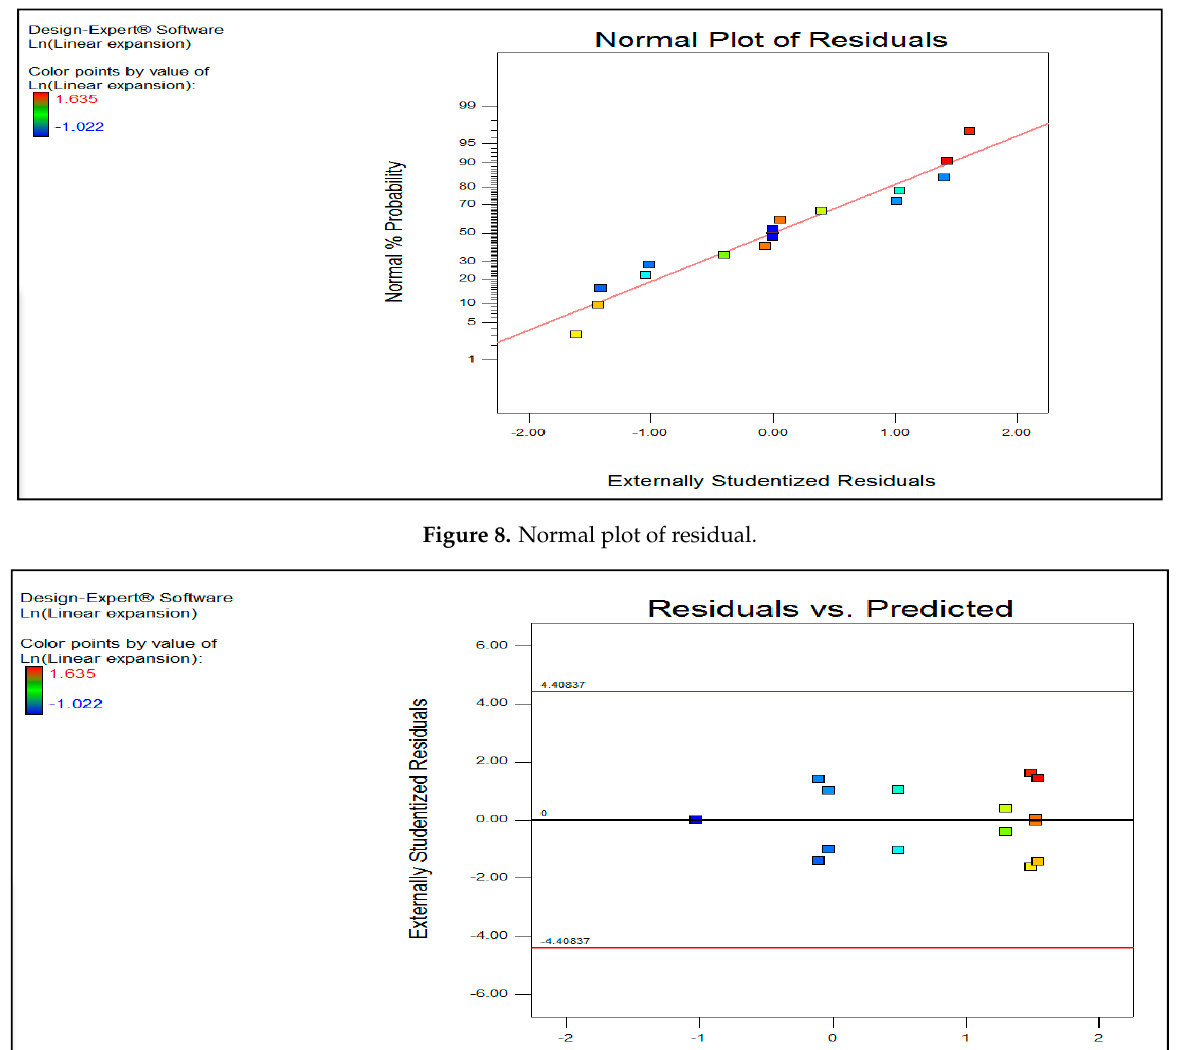
Figure 10. Residual versus experimental run.